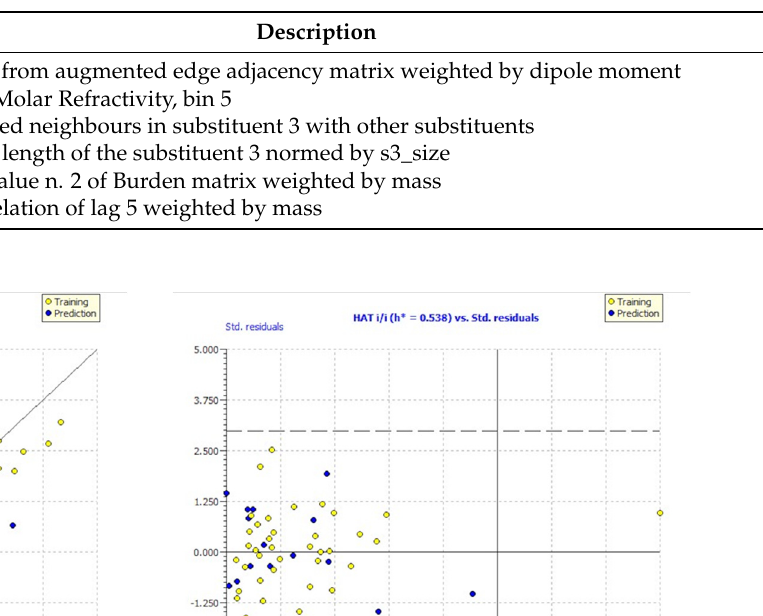
Table 2. Molecular descriptors and their description.